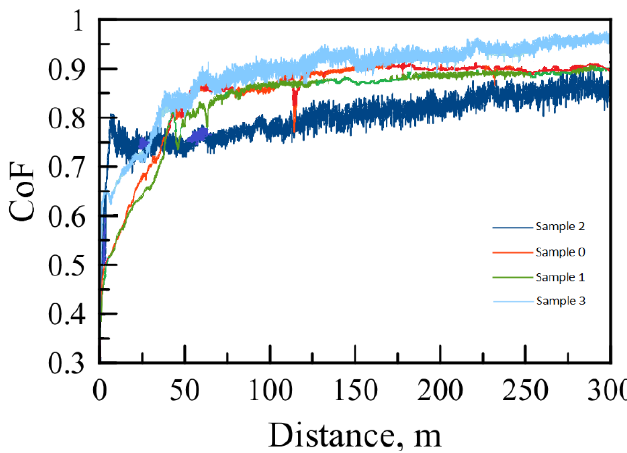
Figure 8. Sliding friction coefficient dependence on the distance.